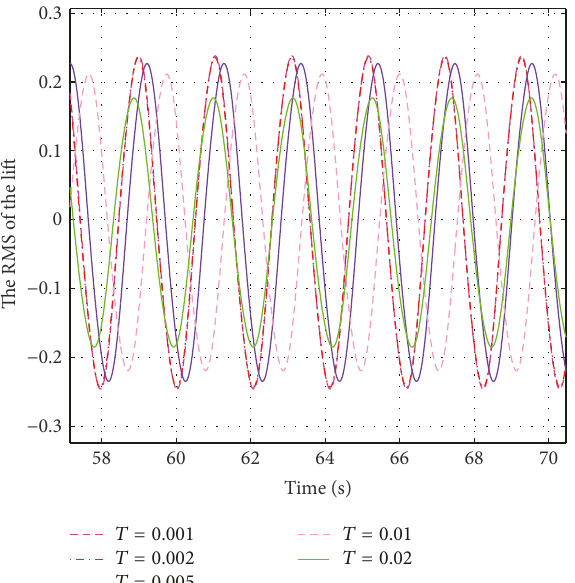
Figure 7: The lift coefficient of different time steps.